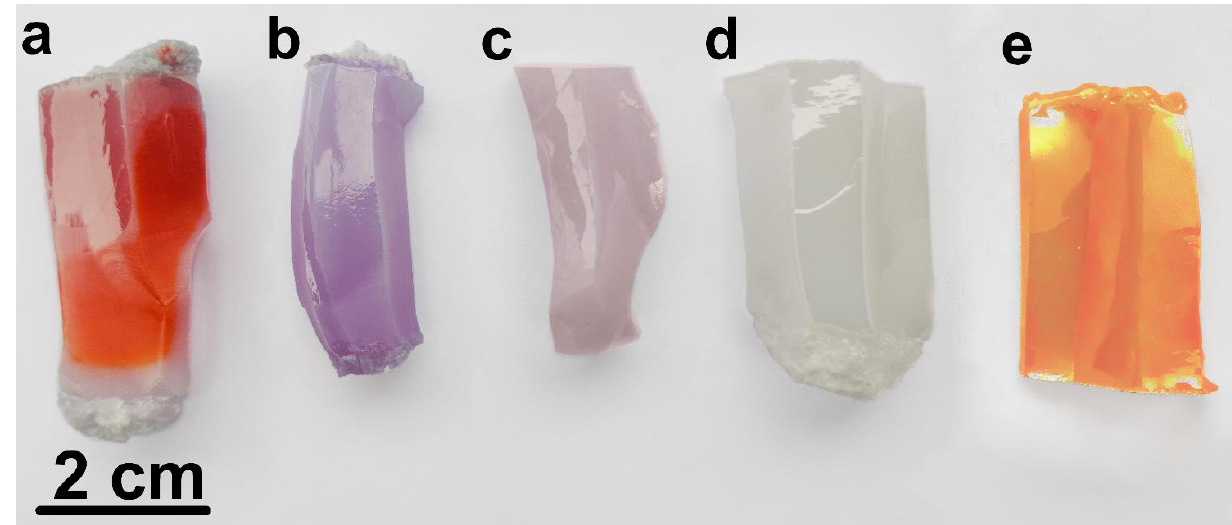
Figure 1. Appearance of ( a ) 2.0Y0.8CeSZ, ( b ) 2.0Y0.8NdSZ, ( c ) 2.0Y0.8ErSZ, ( d ) 2.0Y0.8YbSZ and ( e ) 2.0Y0.8TbSZ crystals. Table 1. Phase composition and tetragonality degree of